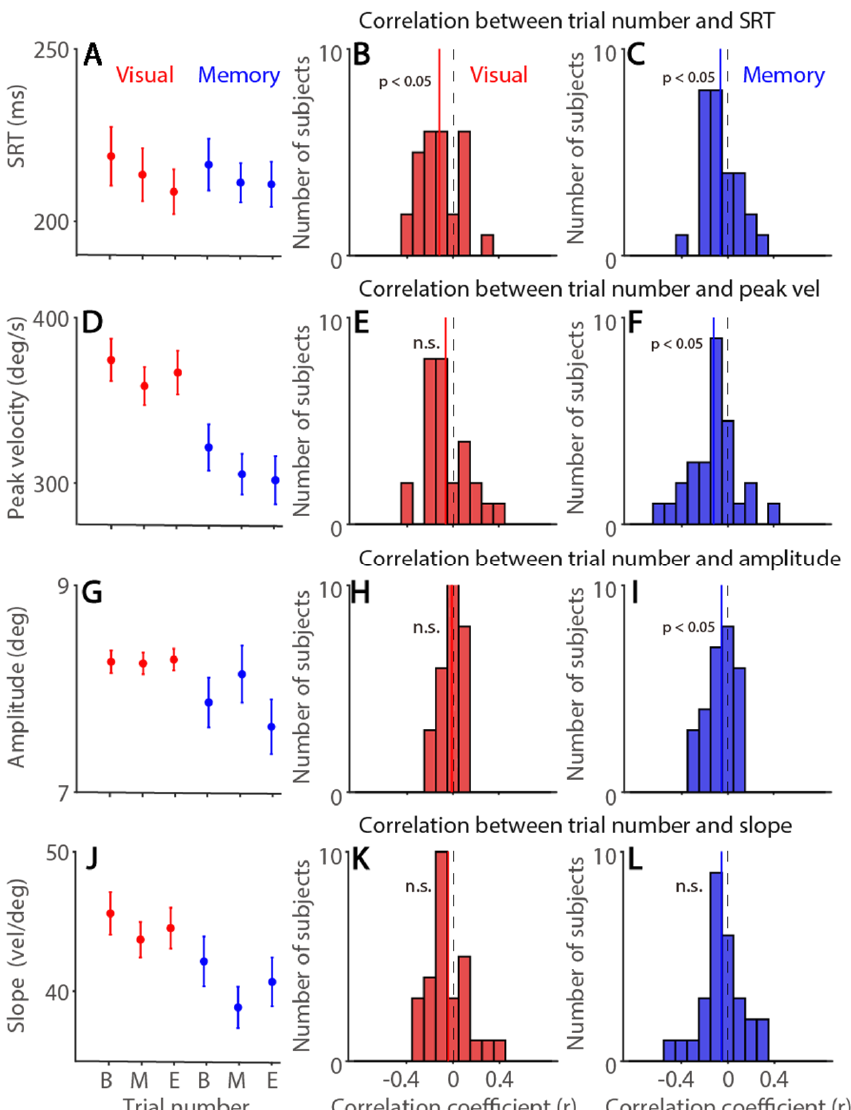
Figure 2. Time-on-task effects on visually and memory-guided saccade latency and metrics. ( A ) Saccade reaction times (SRTs) at different trial number conditions. ( B , C ) Distribution of correlation coefficients for the relationship between trial number and SRT in visually guided ( B ) and memory-guided ( C ) saccades for all subjects ( n = 28). ( D ) Saccade peak velocity at different trial number conditions. ( E , F ) Distribution of correlation coefficients for the relationship between trial number and saccade peak velocity in visually guided ( E ) and memory-guided ( F ) saccades for all subjects. ( G ) Saccade amplitude at different trial number conditions. ( H , I ) Distribution of correlation coefficients for the relationship between trial number and saccade amplitude in visually guided ( H ) and memory-guided ( I ) saccades for all subjects. ( J ) Main sequence slope (peak velocity/amplitude) at different trial number conditions. ( K , L ) Distribution of correlation coefficients for the relationship between trial number and slope in visually guided ( K ) and memory-guided ( L ) saccades for all subjects. The error bars represent ± standard error range (across participants). The vertical black dashed line represents a zero value of the correlation coefficient (r = 0), and the vertical colored line represents the mean value of the correlation coefficient. Visual: visually guided saccade task. Memory: memory-guided saccade task. B: begin, M: mid, E: end. SRT: saccade reaction times. n.s.: not significant.